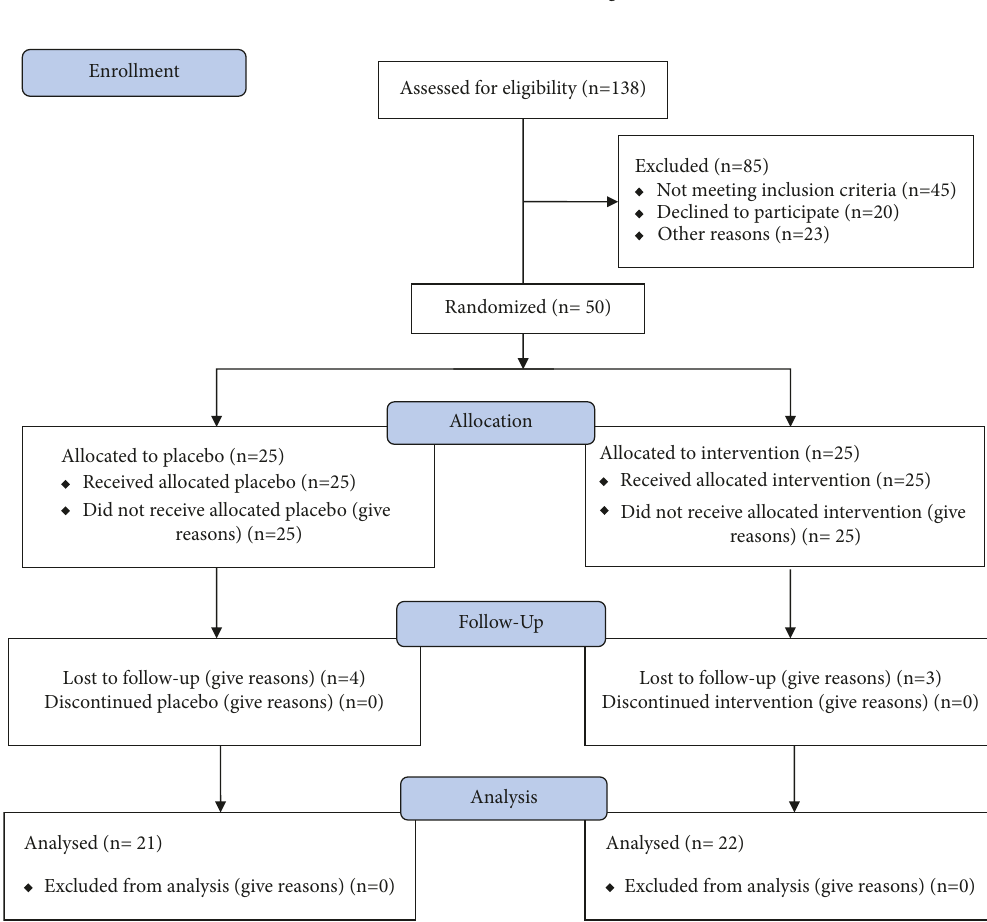
Figure 1: Flow diagram of subjects throughout the